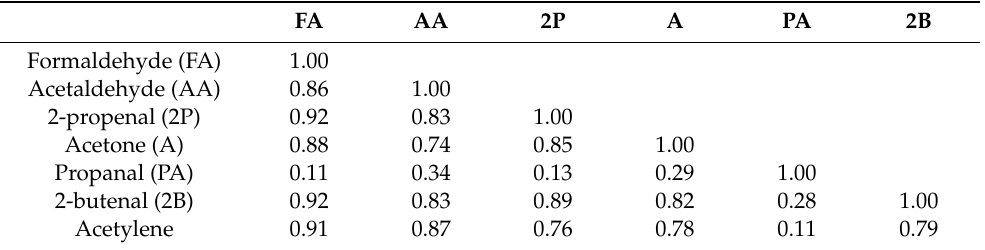
Statistically significant correlations with r > 0.7 are